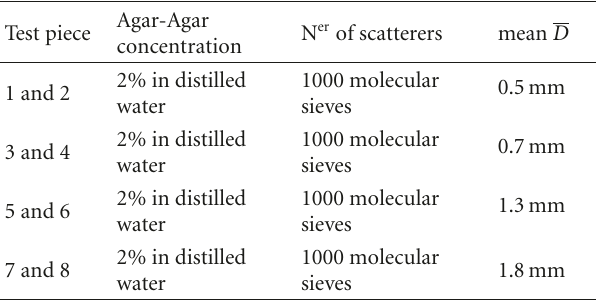
Table 1: Composition of the test